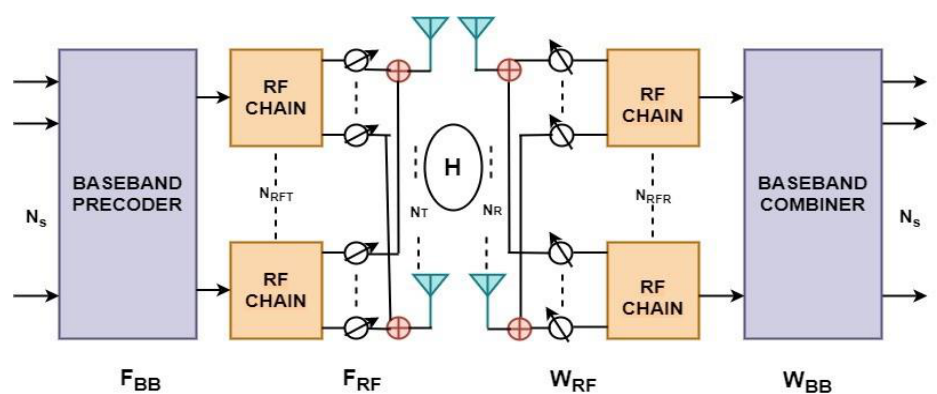
Figure 2. Hybrid precoding in a millimeter system.